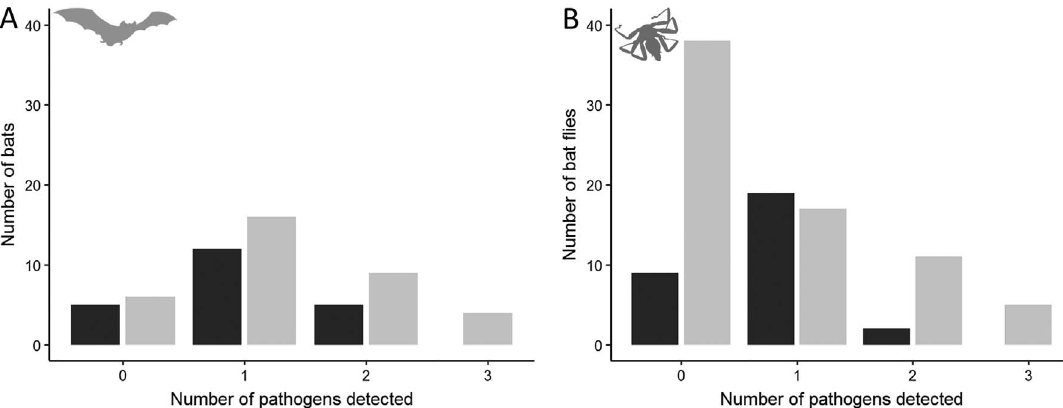
Figure 1. Number of detected vector-borne microorganisms in bats (A) and bat fl ies (B). Black colour corresponds to Miniopterus natalensis (A), and Nycteribia schmidlii scotti (B), whereas grey shows Miniopterus schreibersii (A) and Nycteribia schmidlii